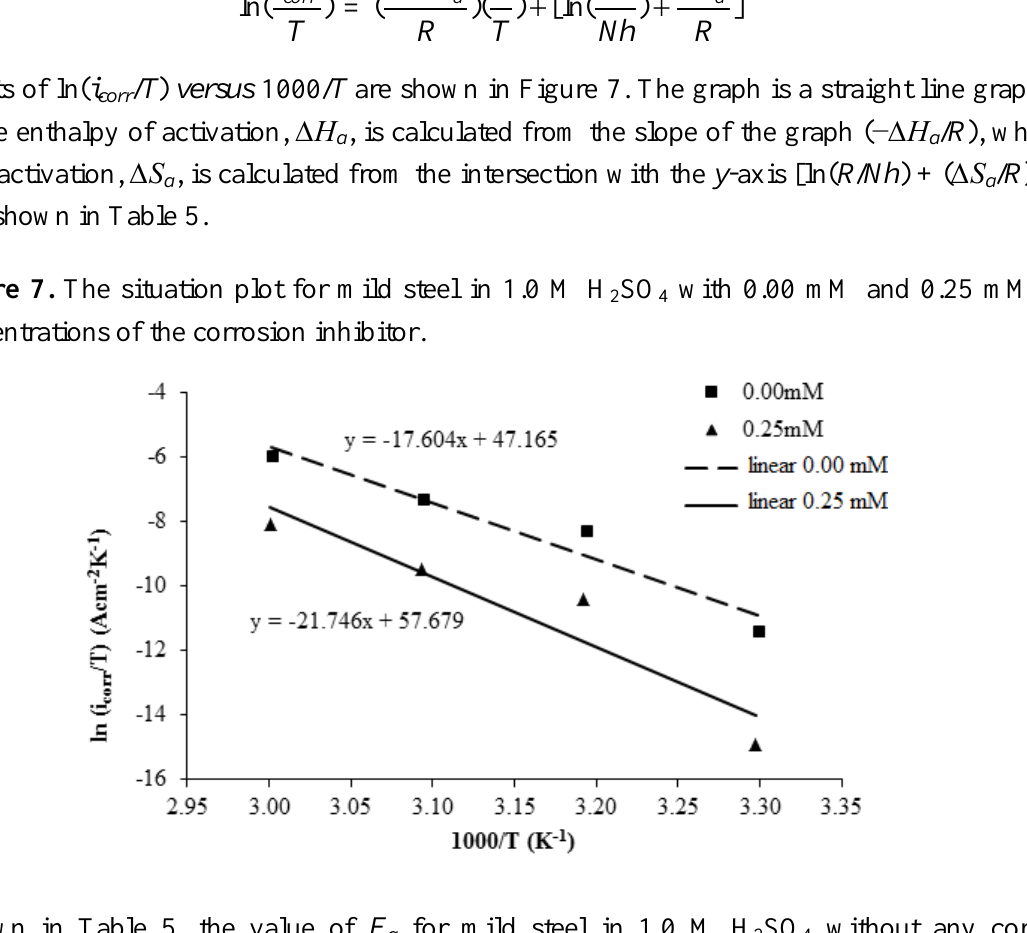
SO with 0.00 mM and 0.25 mM 2 4